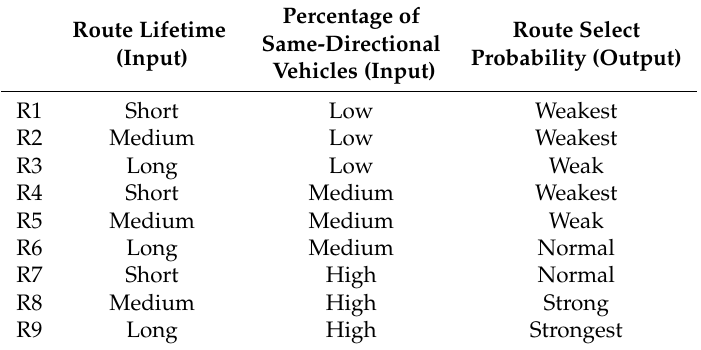
Table 4. Rule base for fuzzy-control-based ad hoc on-demand distance vector (AODV) routing (FCAR) protocol